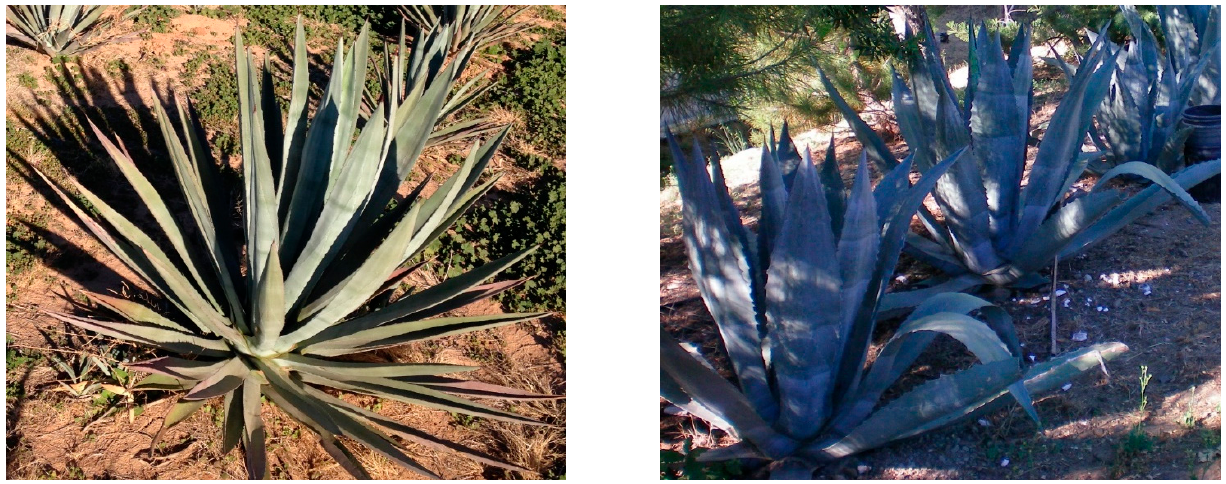
Figure 5. Straight leaves characteristic of Agave fourcroydes ( left ) and mixture of straight and curled leaves characteristic of Agave americana ( right ).